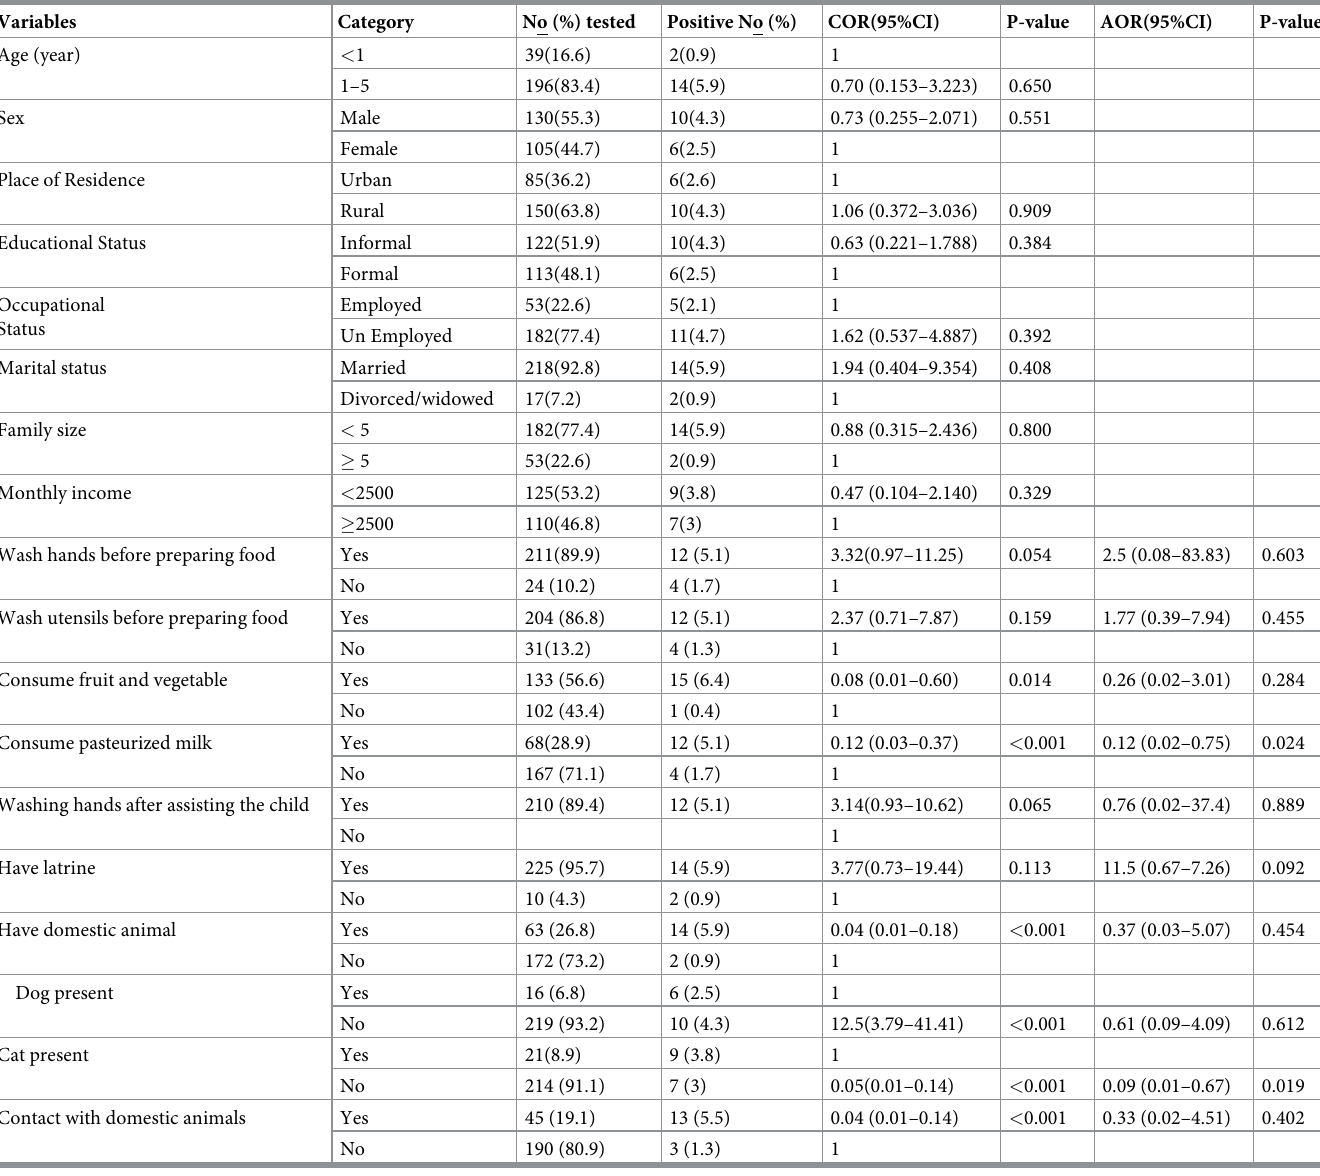
Table 4. Logistic regression analyses for identifying factors association Campylobacter infection among under-five diarrheic children in Hawassa city, Sidama, Ethi- opia, 2021.